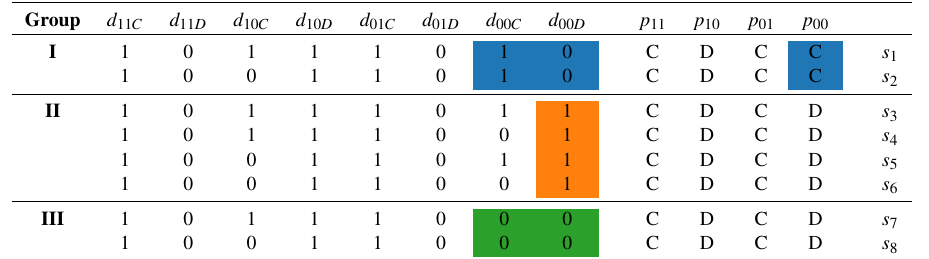
Table 2. The leading eight social norms 23 . The left eight columns contain the reputational update and the right four columns represent action response. An agent with reputation m interacting with another agent with reputation n will cooperate/defect according to p mn . Similarly, the opposing agent will act according to p nm . New reputations after interaction are assigned as d mnp and d nmp mn nm